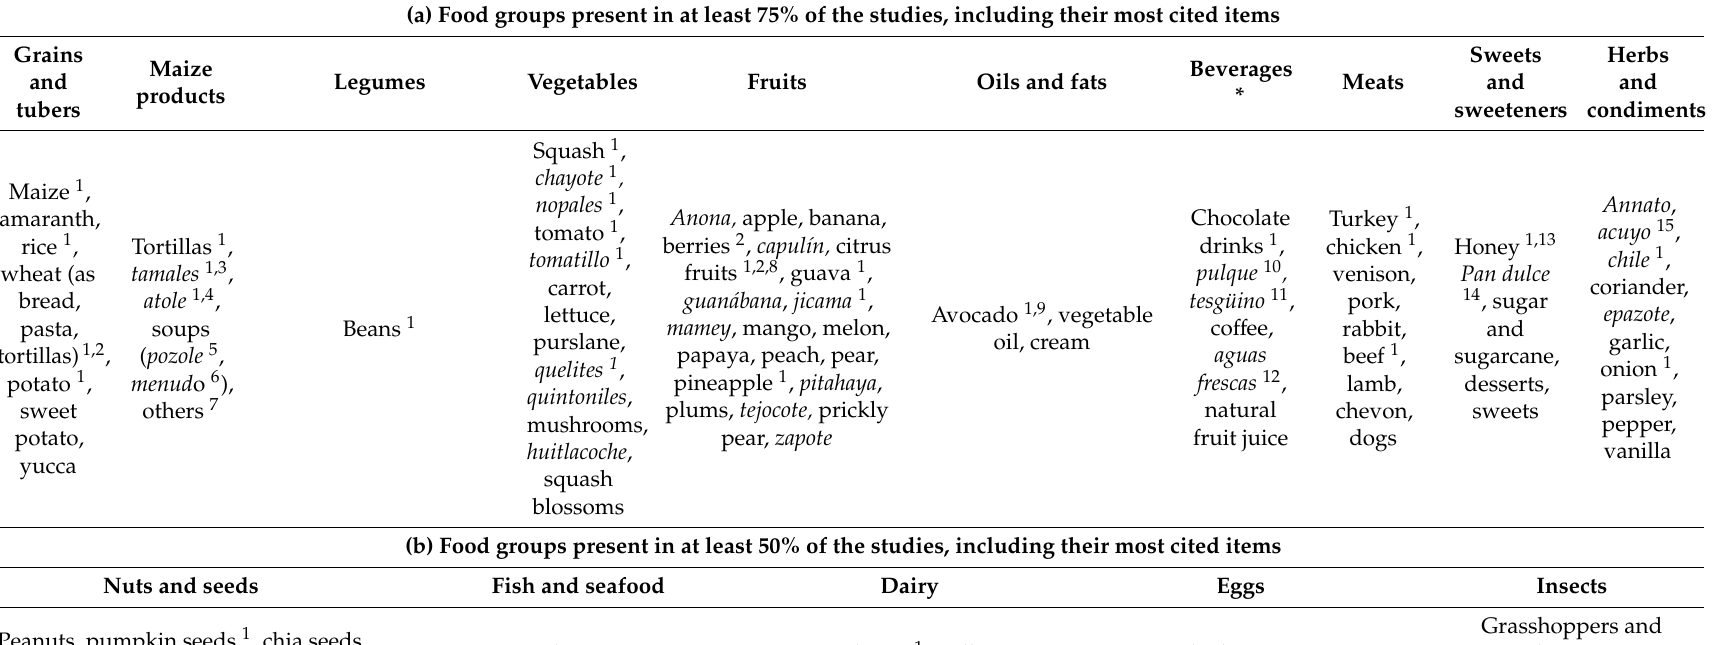
Table 8. Most cited items and food groups present in studies referring to all regions of Mexico ( n =